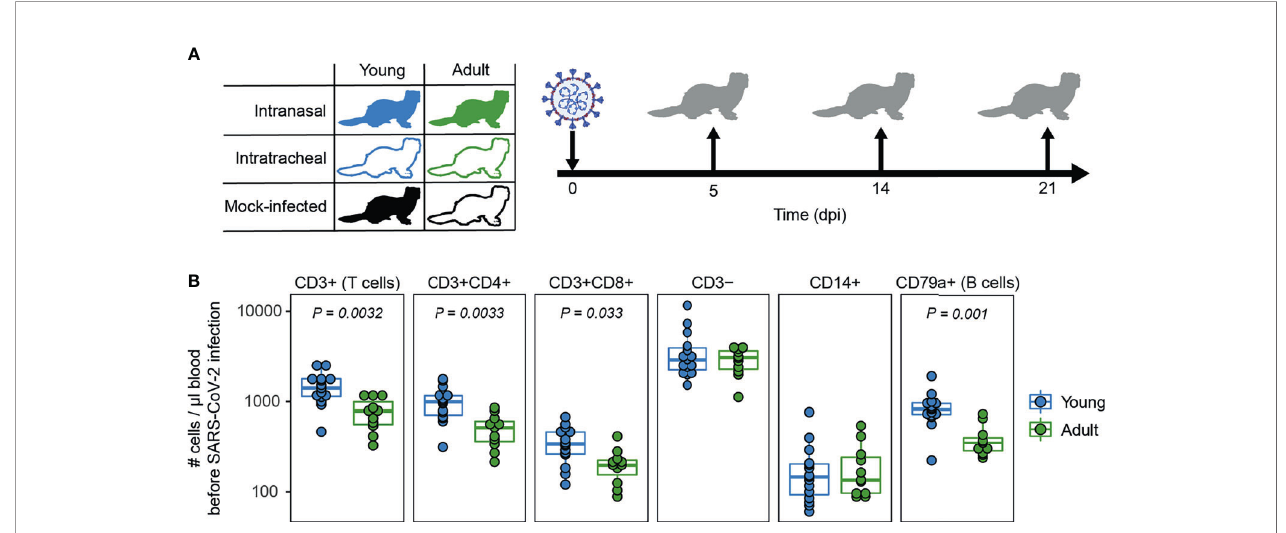
FIGURE 1 | Study outline and immunological pro fi le of young and adult ferrets. (A) Young and adult ferrets were inoculated intranasally or intratracheally with 10 7 TCID 50 SARS-CoV-2 on day 0. On 5, 14 and 21 days post infection (dpi), 3 ferrets were euthanized per group. Mock-infected ferrets were euthanized on 14 dpi (young) and 21 dpi (adult). No intranasally inoculated adult ferrets were euthanized at 14 dpi due to limited availability of adult ferrets. (B) Cell counts in blood of uninfected young and adult ferrets. N = 15 for young animals and n = 11 for adult animals. Boxplots depict the median with the fi rst and third quartiles. Differences between young and adult ferrets were tested via a two-sample Wilcoxon test and corrected for multiple testing using the Holm method. Panel (A) was created using